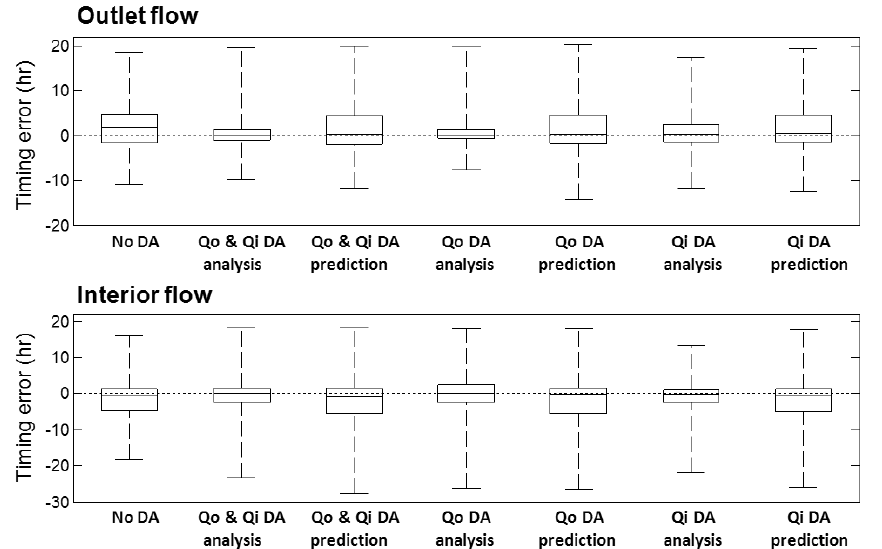
Fig. 12. Timing error estimates in the simulation of outlet and interior flows. The box-plot characterises both inter-basin and event-to-event